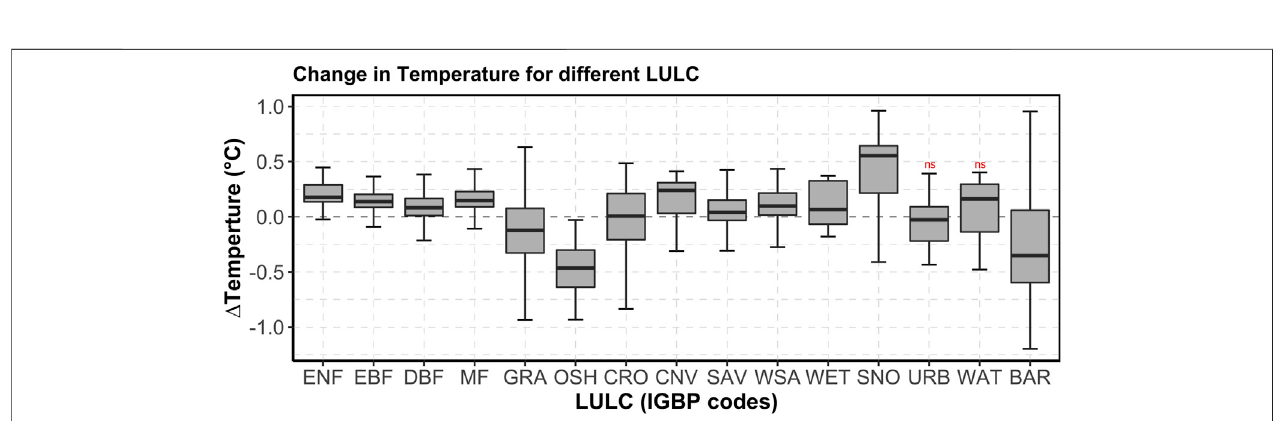
FIGURE 7 | Mean changes in temperature (2015 – 2002) across different land-use/land-cover (LULC) types. The LULC is shown as International Geosphere- BiographProgram(IGBP) codesof land cover. The “ ns ” above the error-point denotes that the mean and median change wasnot signi fi cantly different from zero asper t -test and Wilcoxon rank sum test, respectively. The error bar shows the standard deviation of all the data points.